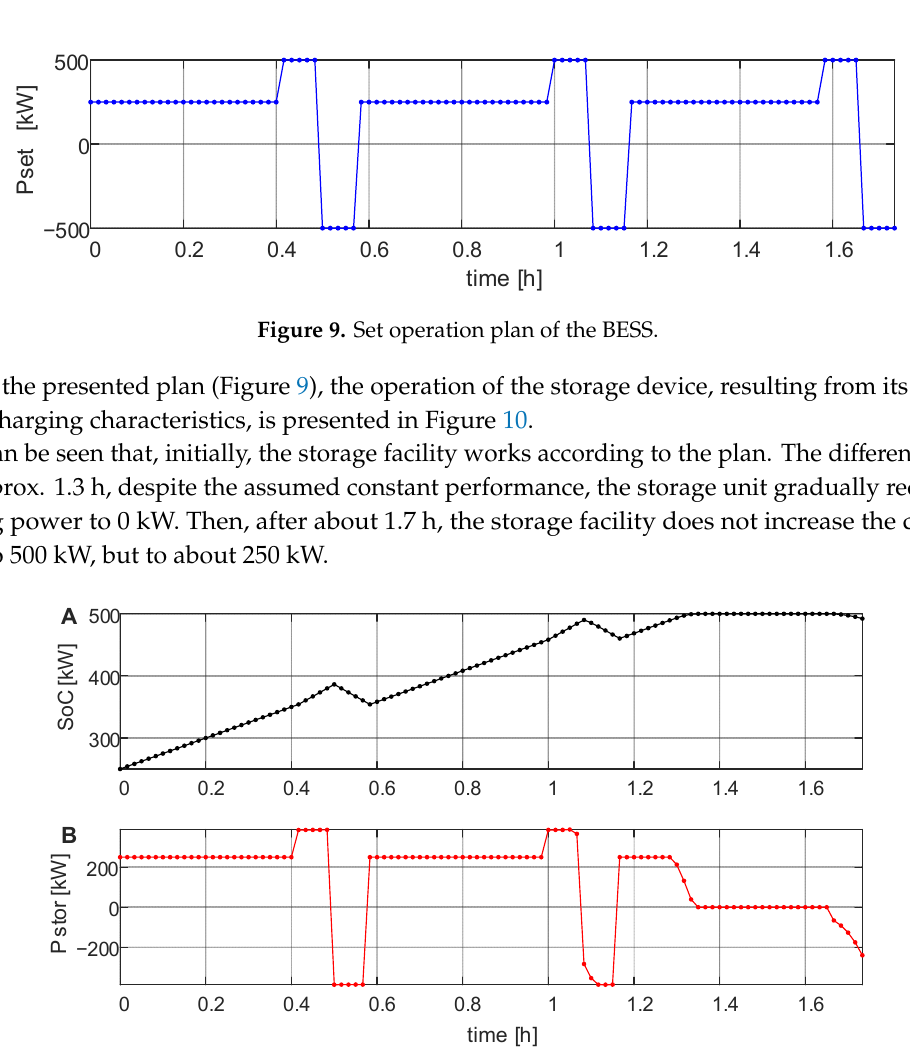
Figure 10. Operation resulting from the charging and discharging characteristics of the BESS with the real characteristics ; change of energy accumulated in the BESS over time ( A ); change of BESS charging and discharging power over time ( B ).